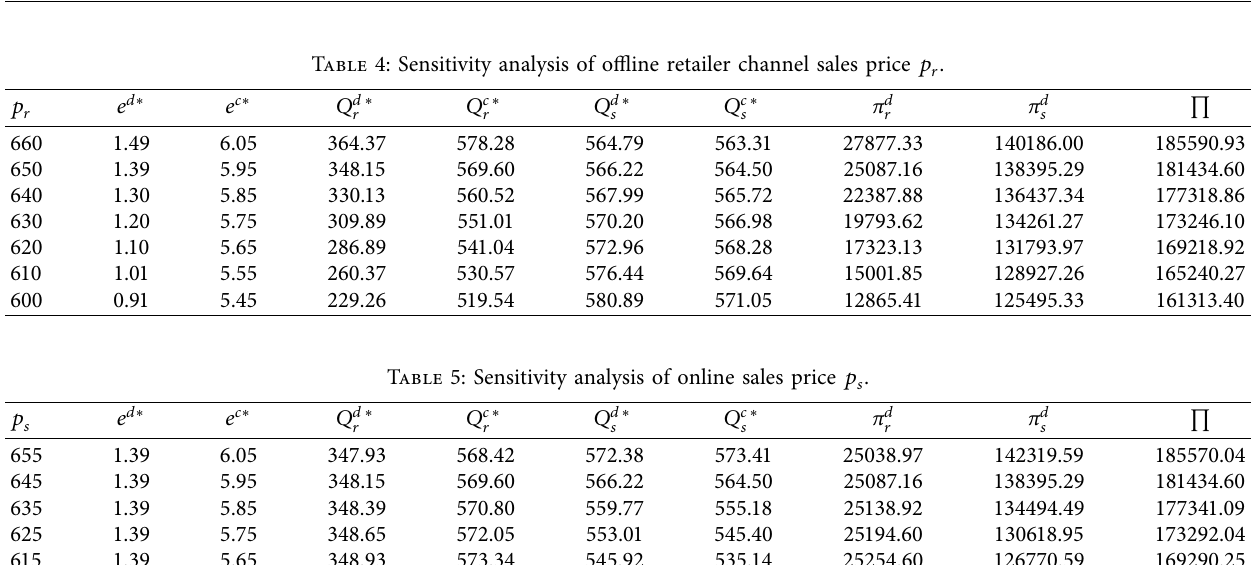
Table 4: Sensitivity analysis of offline retailer channel sales price p